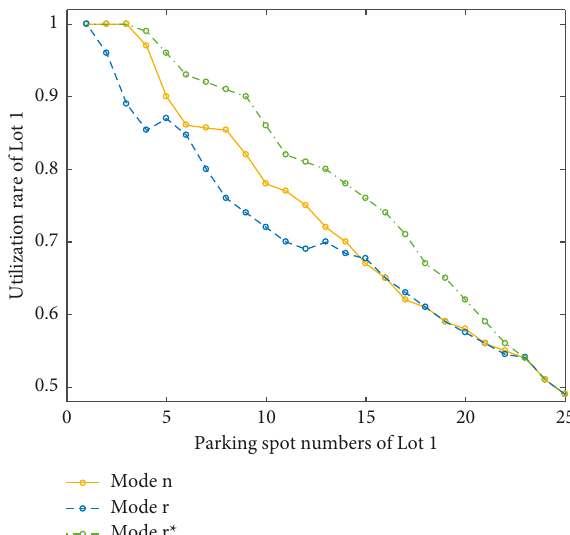
Figure 13: Usage of parking lot 1 in mode r